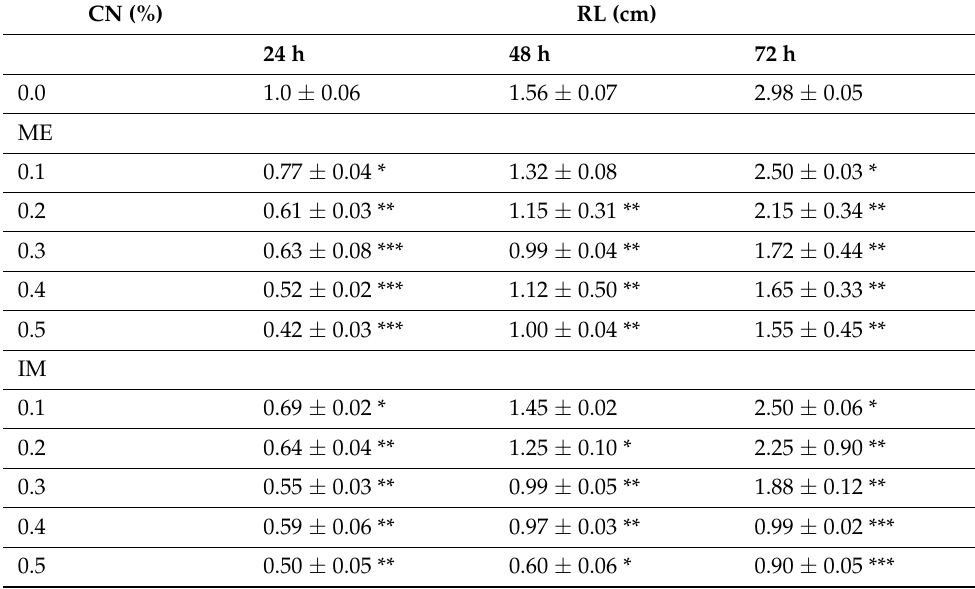
Figure 3. Seed germination (SG) in P. sativum seeds exposed to imidacloprid (IM) for ( A ) 1 h, ( B ) 3 h, and ( C ) 6 h at 24, 48, and 72 h after exposure. Data represent mean and SE. The experiment was repeated thrice. * p < 0.05; ** p < 0.01 and *** p < 0.001 compared to control at respective time interval. Table 1. Effect of ME and IM on RL of P. sativum at different concentrations for 1